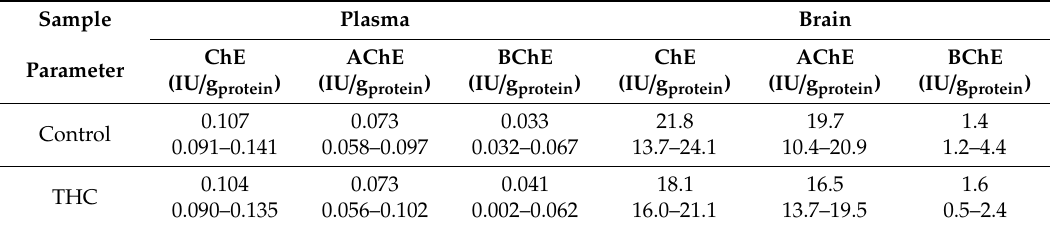
Table 2. Changes in the total cholinesterase activity (ChE), acetylcholinesterase activity (AChE) and butyrylcholinesterase activity (BChE) in plasma and brain of male Wistar rats after 1-day treatment with ∆ 9 -tetrahydrocannabinol (THC) and in the respective